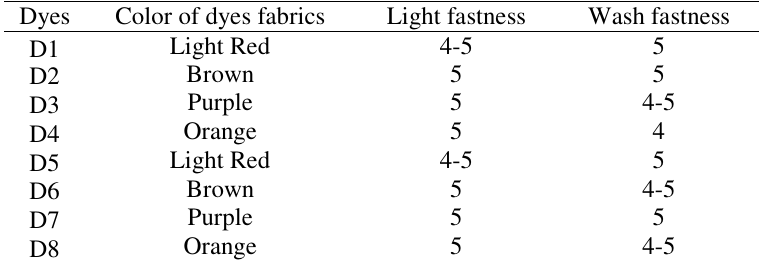
Table 2. Shades and fastness properties of dyes